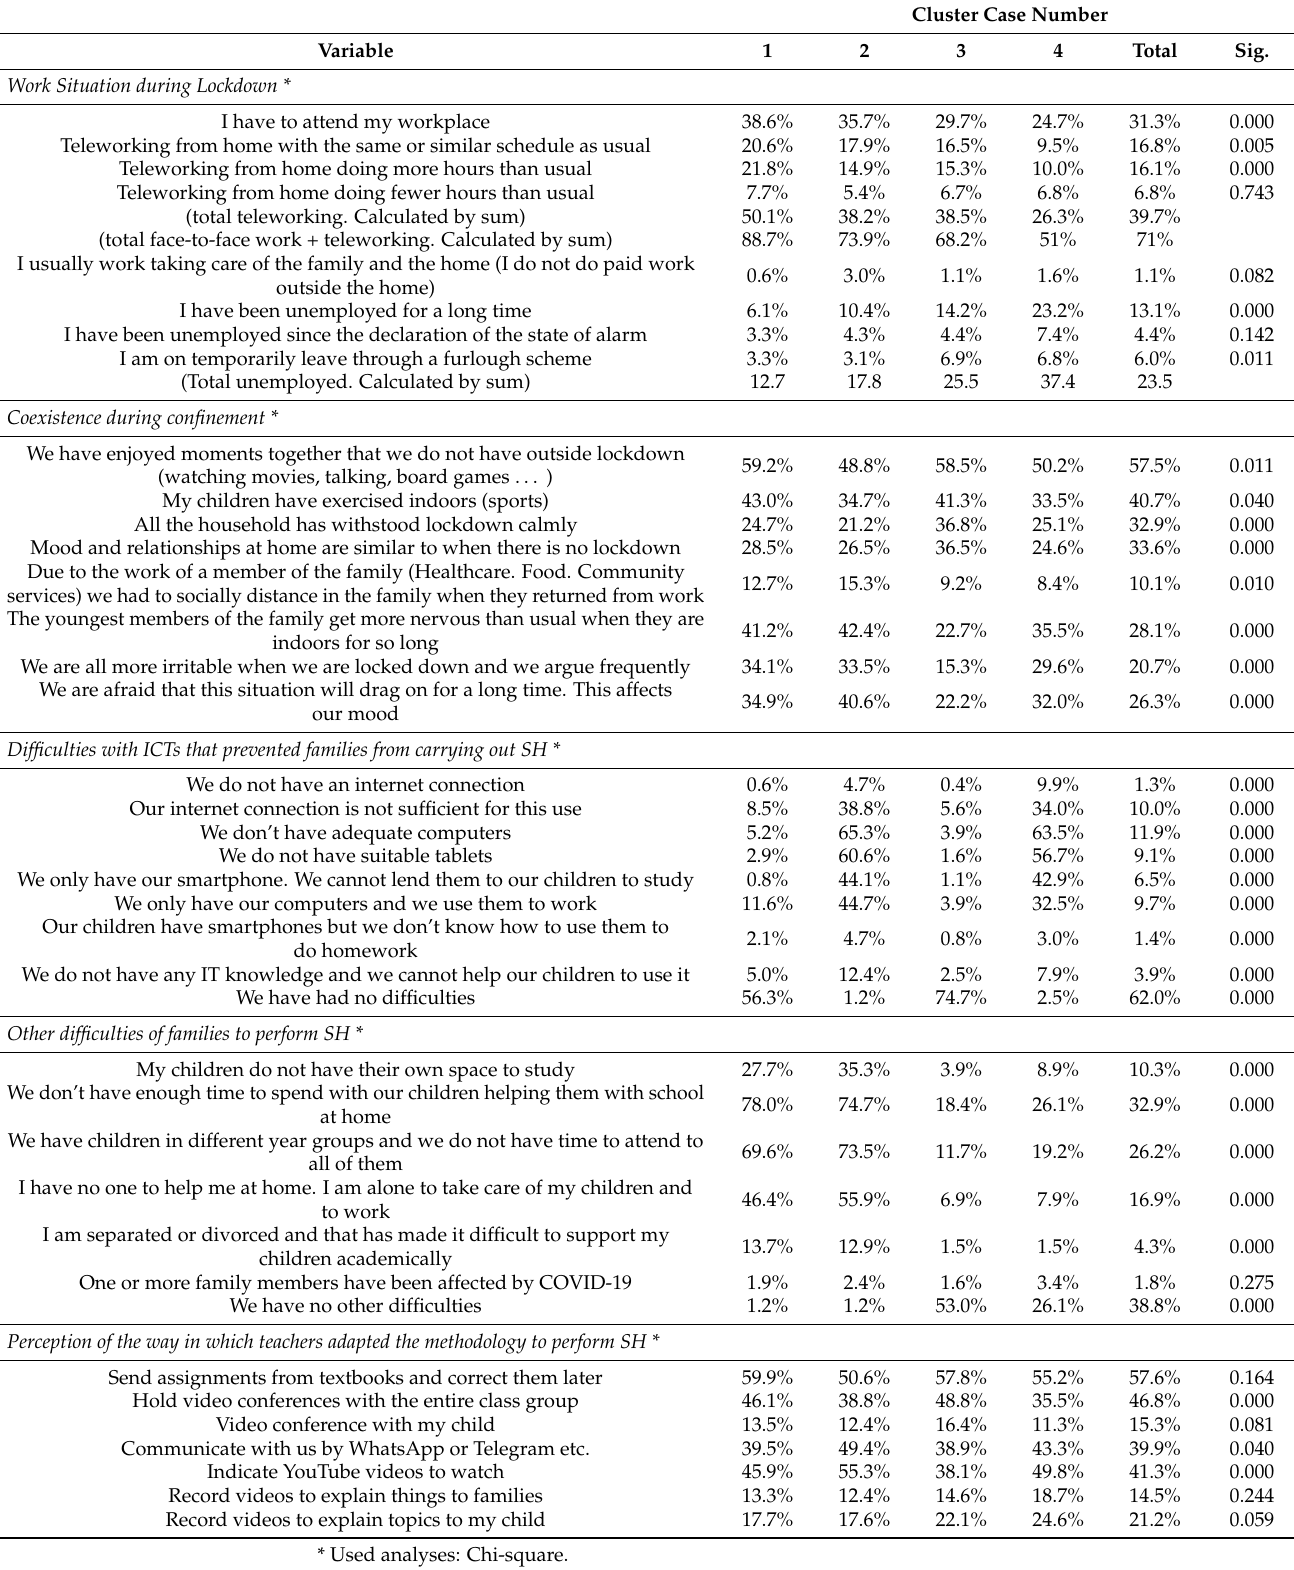
Table 6. Families’ perceptions of the SH functioning in the VC and its association with